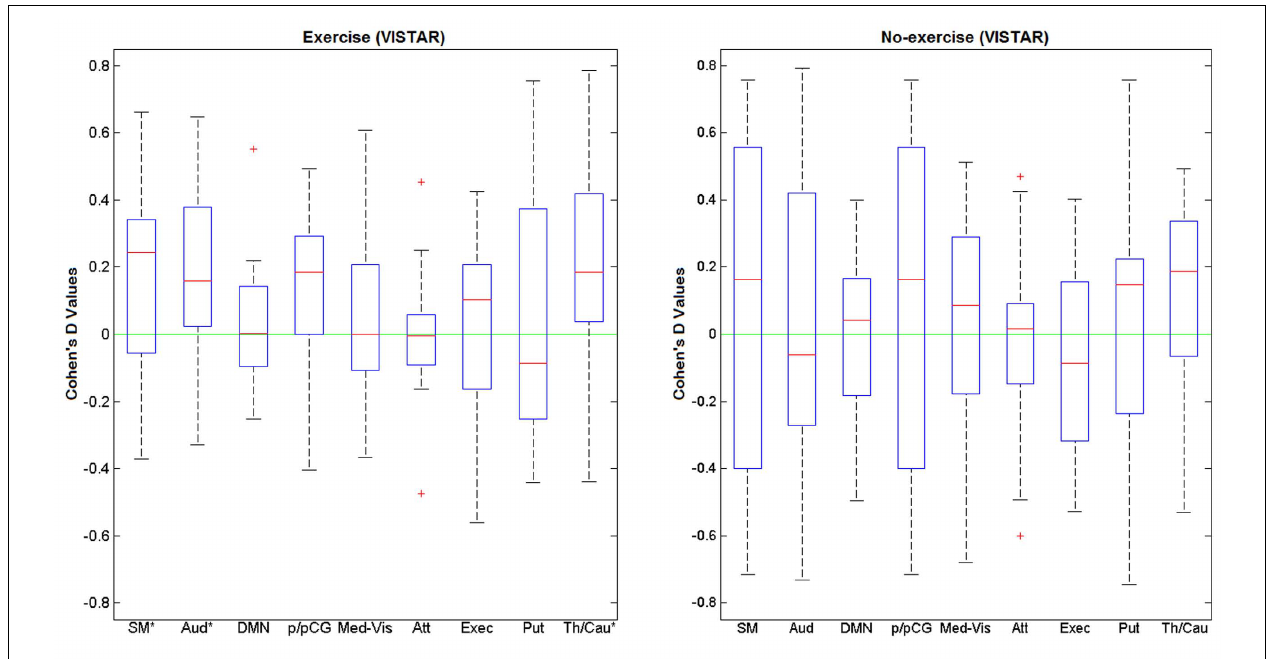
FIGURE 4 | Cohen’s D values of for the nine RSNs of interest using exercise ( N = 15) and no-exercise ( N = 15) datasets (VISTAR). SM, sensorimotor; Aud, auditory; DMN, default mode network; p/pCG, pre and post central gyri; Med-Vis, medial visual; Atten, attention; exec, executive; Put, putamen;Th/Cau, thalamus and